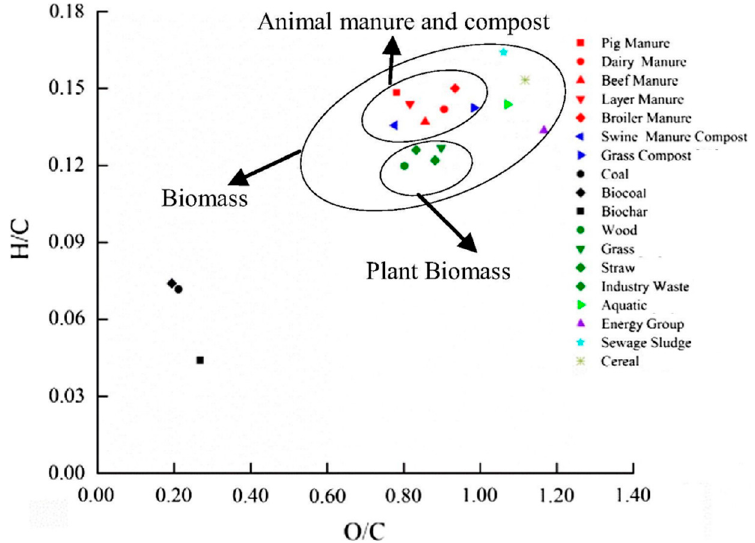
Figure 2. Van Krevelen diagram representing the heating values of the different types of animal manures, compared with solid fuels. Adapted from Shen et al. 2 [22] with permission from Elsevier.